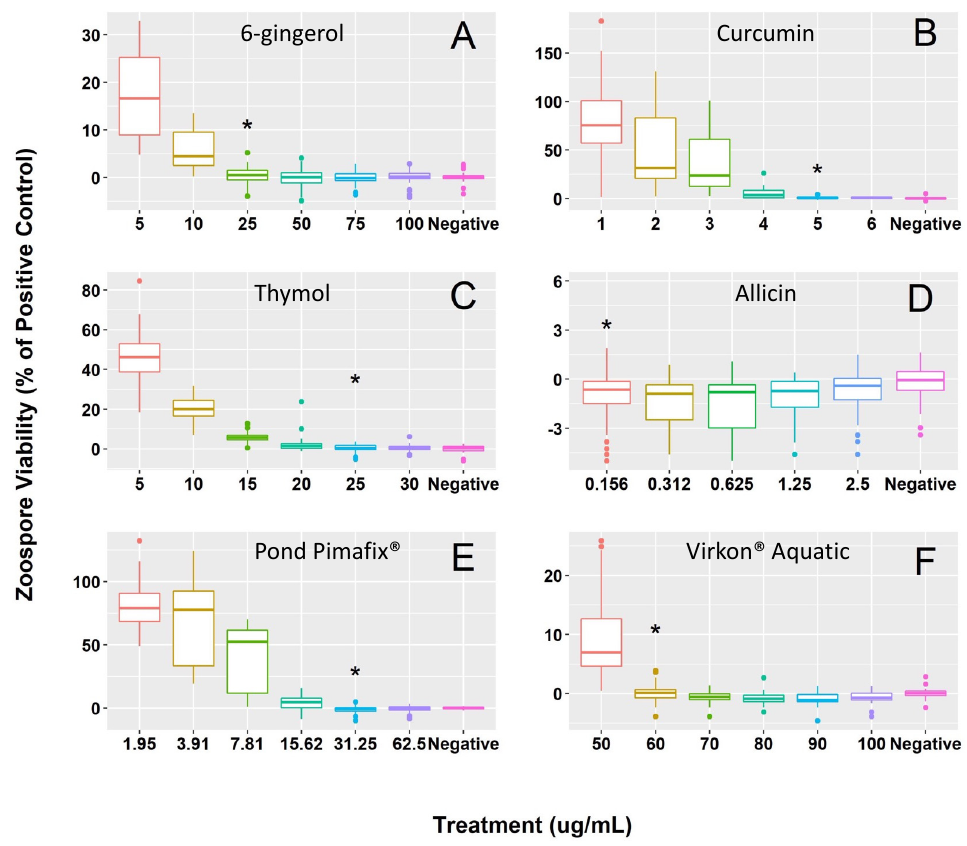
Figure 1. Bsal zoospore viability (% of the positive control) of the six tested concentrations and minimum inhibitory concentration [MIC] of ( A ) 6-gingerol [25 µ g/mL], ( B ) curcumin [5 µ g/mL], ( C ) thymol [25 μ g/mL], ( D ) allicin [0.156 μ g/mL], ( E ) Pond Pimafix ® [31.25 μ g/mL], and ( F ) Virkon ® Aquatic [60 μ g/mL]. An asterisk (*) is above the MIC for each fungicide. Each box plot represents Bsal zoospore viability relative to the positive control ( Bsal zoospores in half-strength TGhL broth) for each concentration tested per fungicide ( n = 45 wells per concentration across all plates). Midlines in each boxplot denote the median and the upper and lower sections of each box represent the first and third quartiles. Colored points extending beyond the boxplot represent outliers. As mentioned in the main text, “%” values can be negative based on the standard equation that we used if observed values are less than the negative control. 4. Discussion All of the fungicides we tested were successful at inhibiting growth and killing Bsal zoospores at relatively equivalent or lower concentrations compared to previous studies with other fungal pathogens. Silva et al. [19] tested the efficacy of 6-gingerol, allicin, and curcumin against Bd and found that all three were toxic to zoospores (i.e., killing at least 50% of the zoo- spore population within 24 h). However, the MICs of curcumin, 6-gingerol, and allicin for Bd zoospores were approximately 20%, 10×and 20× greater than for Bsal . Differences in efficacy could be partly related to fungicide exposure duration between our study (72 h) and Silva et al. [19] (24 h). Bsal